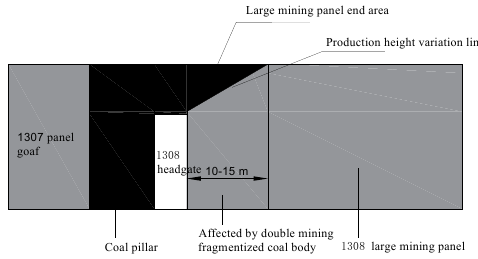
Figure 1. Layout of the large mining height coal face roadway.